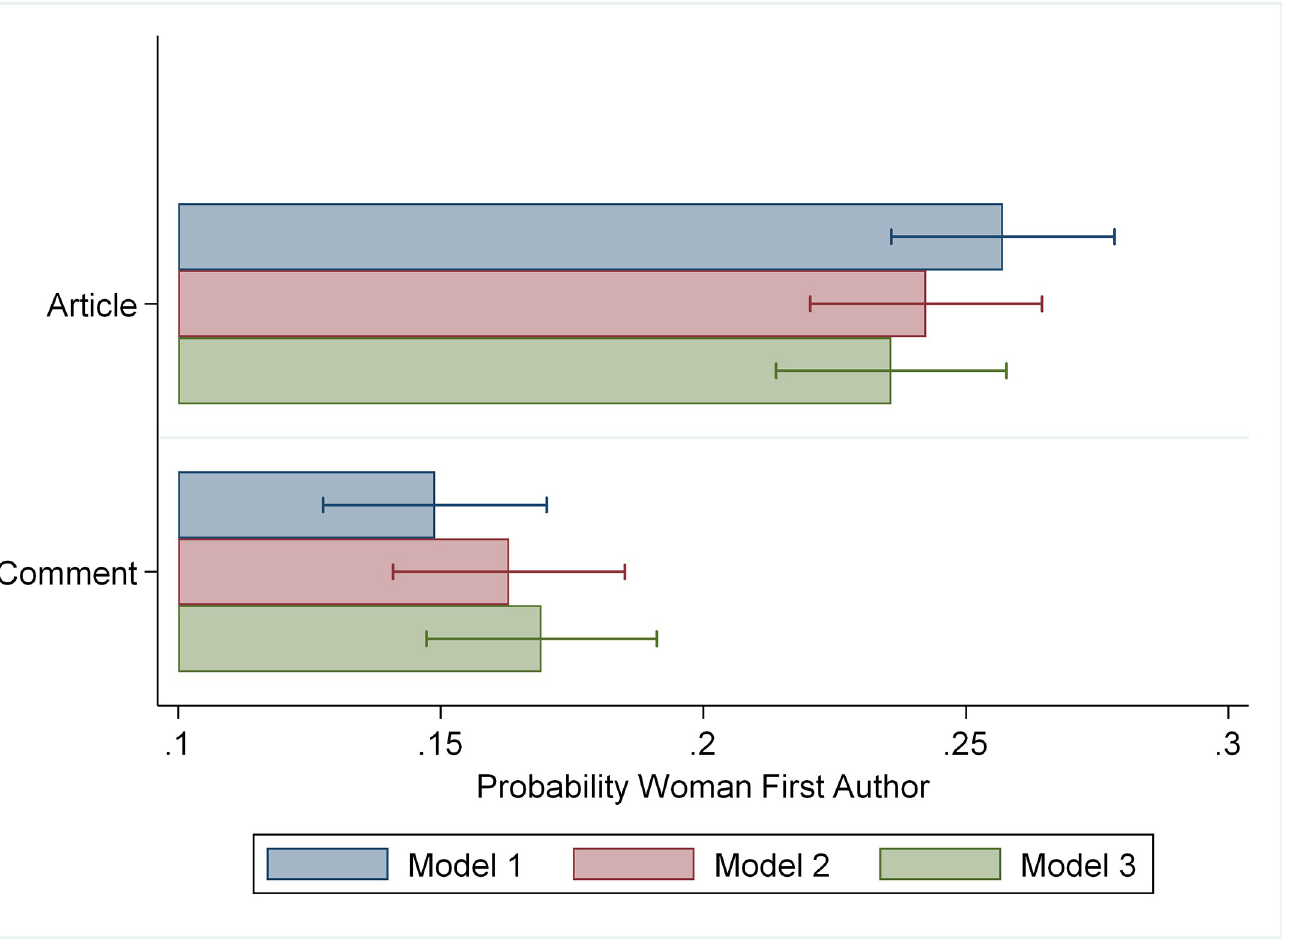
Fig 1. Estimated probability first author is a woman by publication type.